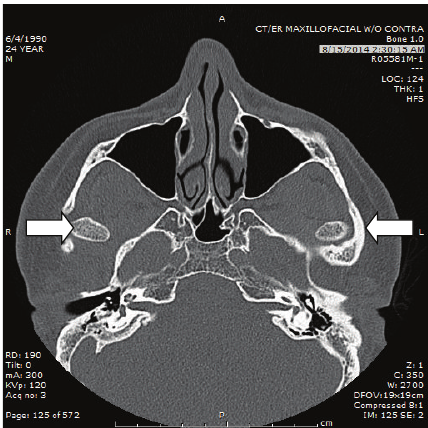
Figure 2: CT showing bilateral condylar heads (arrows) anterior to the glenoid